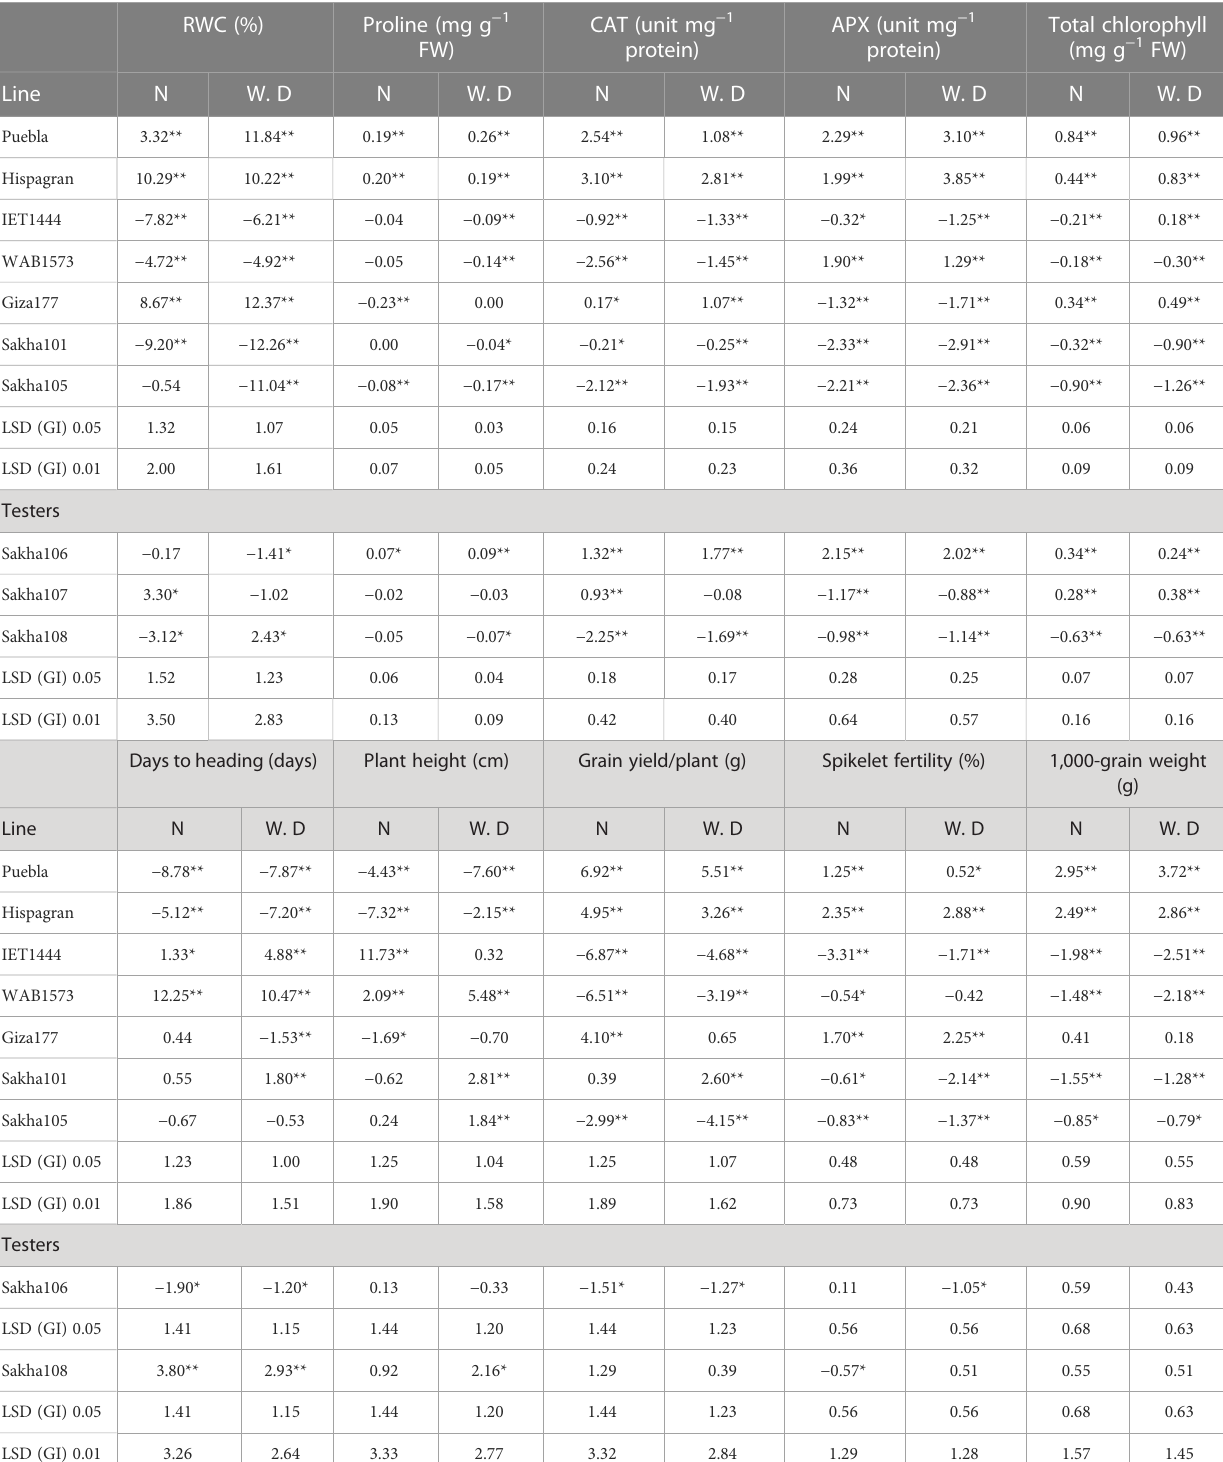
TABLE 4 Estimates of general combining ability (GCA) effects of the parents for physiological, biochemical, and yield-related (and its components) traits under normal watering and water de fi cit